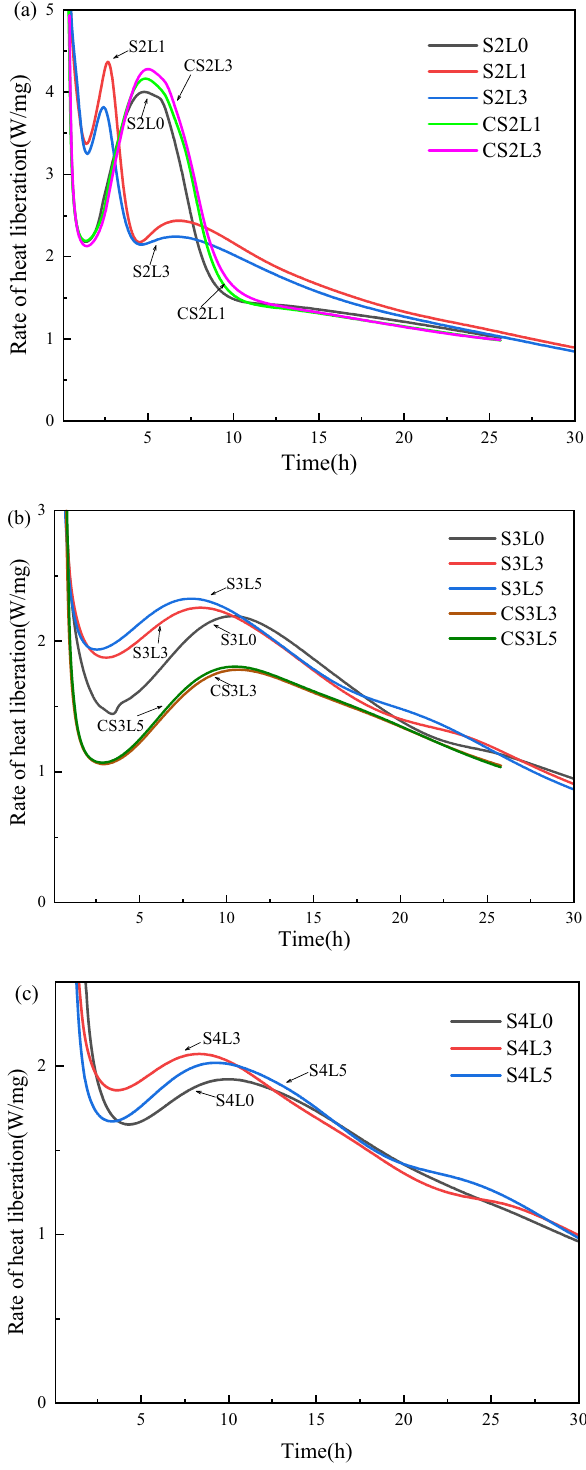
Figure 5: The results of the heat of hydration experiment: ( a ) 2% gypsum, ( b ) 3% gypsum, and ( c ) 4%